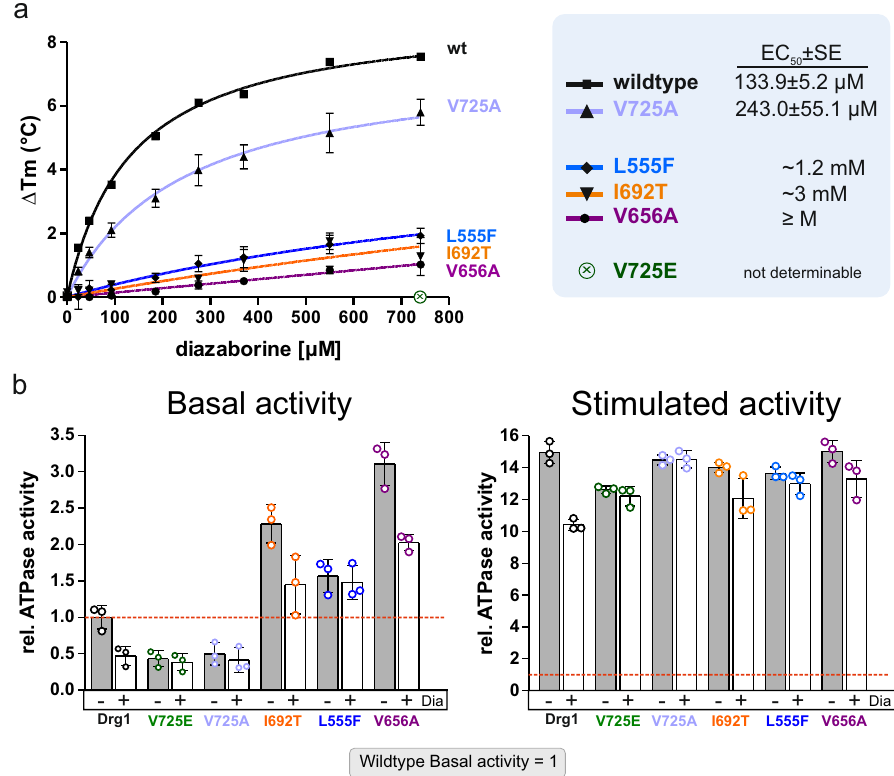
Fig. 5 D2 mutations affect binding of diazaborine and ATPase activity of Drg1. a Drg1 wild type and the indicated mutant variants were puri fi ed and drug binding was measured using DSF assays. Quanti fi cation of the melting point shift ( Δ T m , means and error bars showing standard deviation from 4 to 6 measurements ( n = 4 – 6)) of Drg1 in dependency of the diazaborine concentration was used to calculate the binding af fi nity as EC 50 ± standard error 21 . b The in vitro ATPase activity was measured using the Malachite green phosphate assay. The ATPase activity was determined in the absence (basal activity) and in the presence of the HIS6-tagged C-terminal fragment (amino acids 147 – 199) of the substrate protein Rlp24 (stimulated activity). All samples contained 1 mM ATP. The activities were calculated as speci fi c ATPase activity ( μ mol ATP/h/mg Drg1) and normalized to the basal activity of the wild-type protein (dashed red line). Inhibited activity ( + Dia) was measured in the presence of 100 µ g/ml diazaborine. Error bars represent standard deviations of means calculated from three biological replicates ( n = 3) each measured in triplicate. Source data are provided as a Source data fi